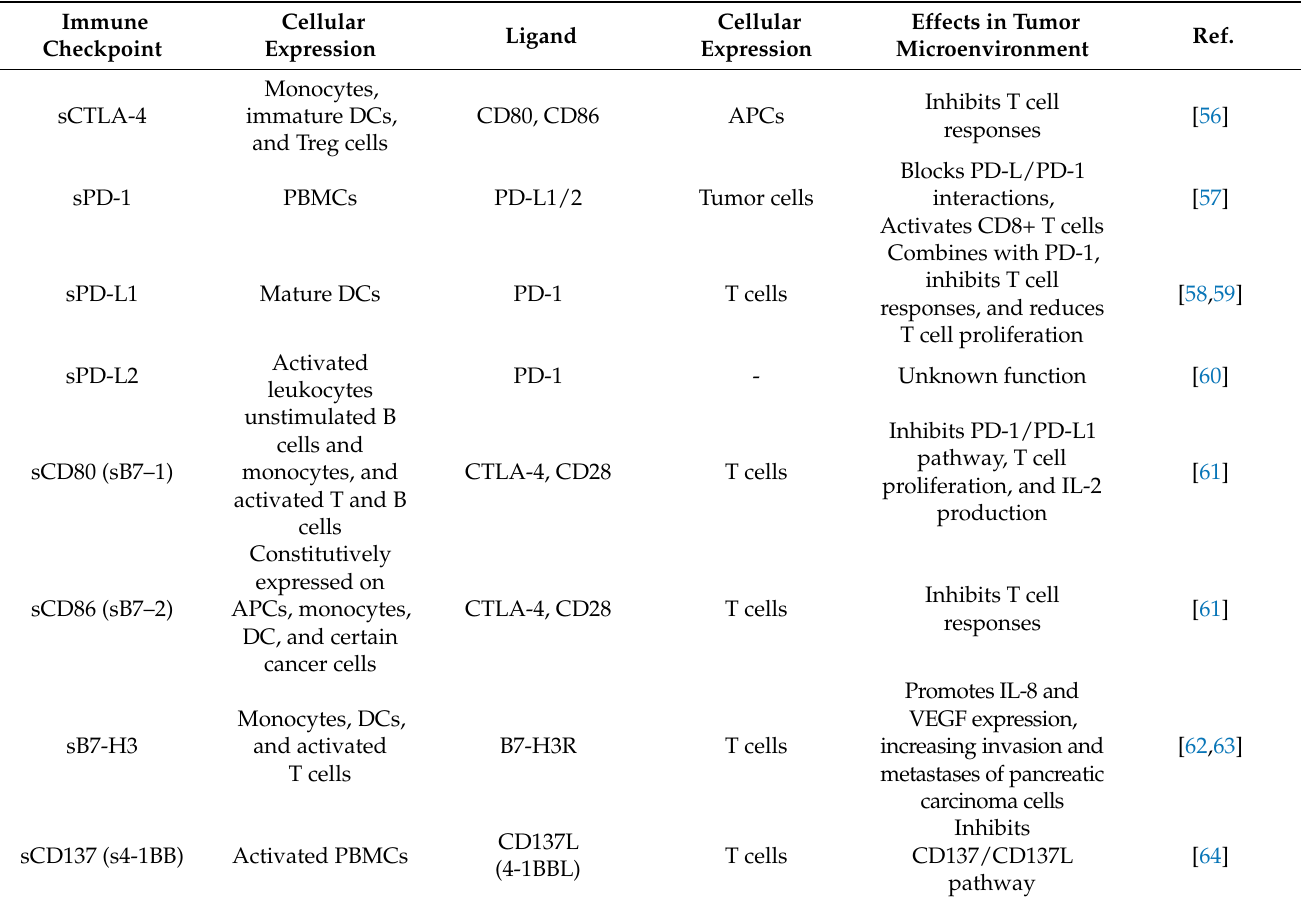
Table 2. Expression pattern of soluble isoform of immune checkpoints (ICs) and their effects on tumor